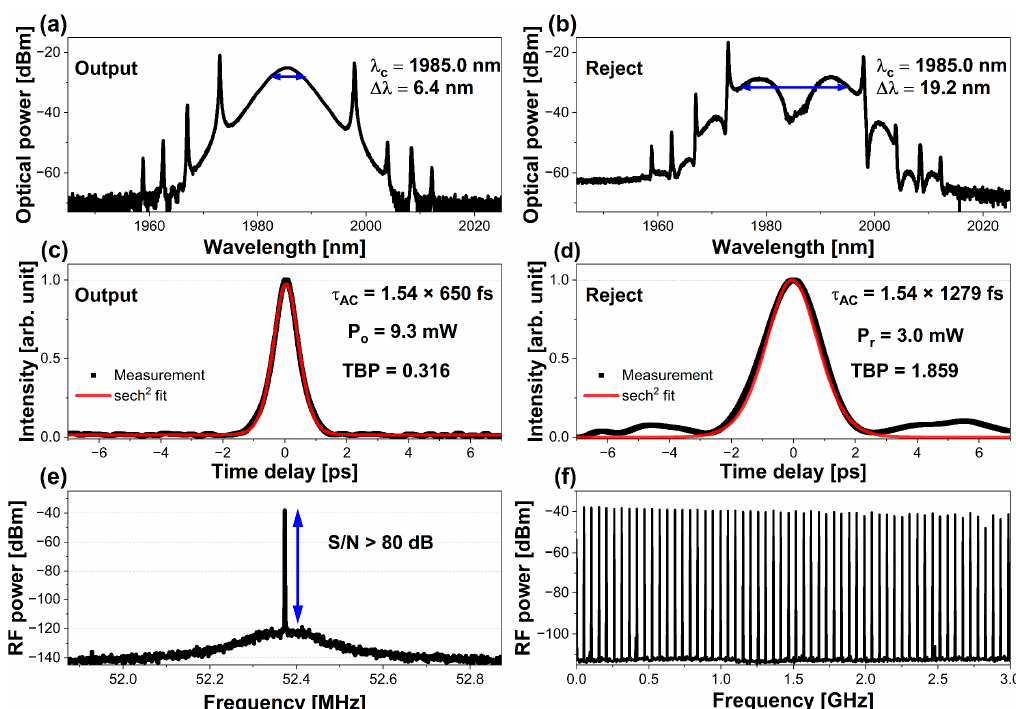
Figure 2. Measured single-pulse operation characteristics. Optical spectrum at the output ( a ) and reject ( b ) port. Autocorrelation trace with sech 2 fit at the output ( c ) and the reject ( d ) port. RF spectrum of the first harmonic ( e ) and the broad spectrum of harmonics in the 3 GHz span ( f ), measured with resolution bandwidth 50 Hz and 1 kHz, respectively.